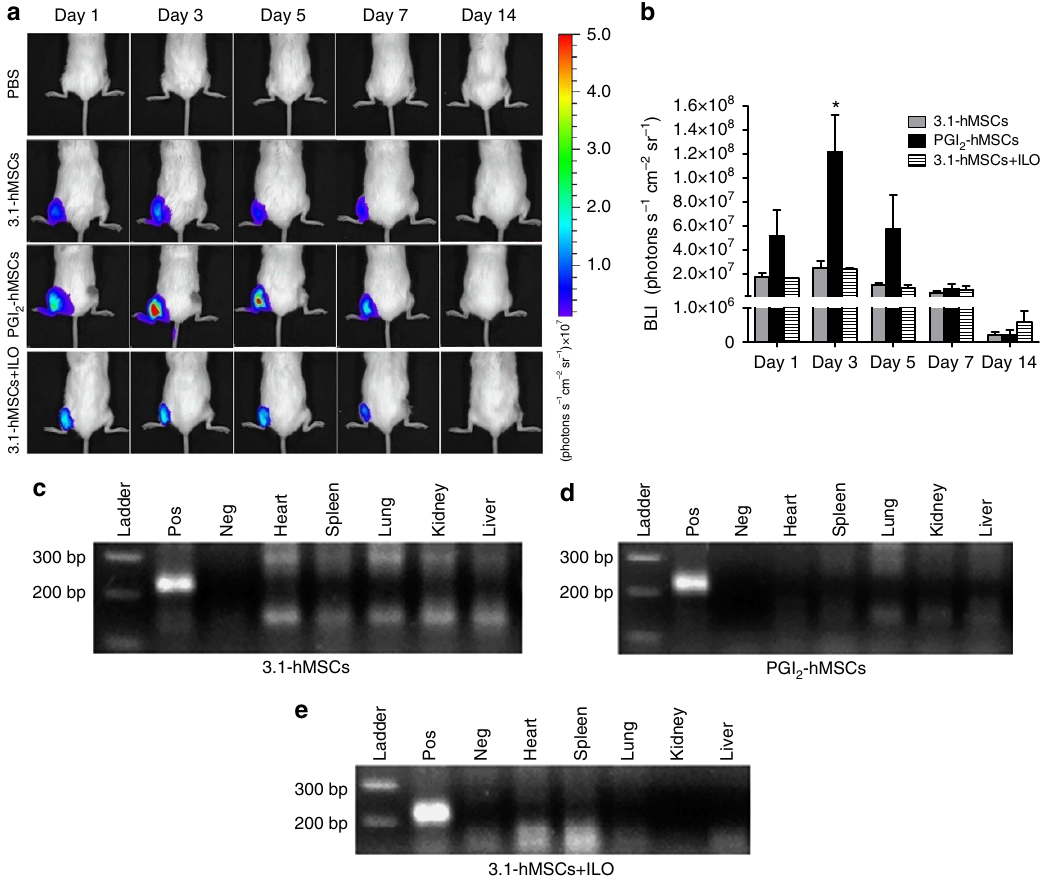
Figure 2 | PGI 2 -hMSCs showed superior acute retention in ischaemic hindlimbs. ( a ) Representative in vivo bioluminescent images of NOD–SCID mice at indicated intervals after injection of vehicle (PBS), 3.1-hMSCs, PGI 2 -hMSCs or 3.1-hMSCs þ ILO into the gastrocnemius muscle of the ischaemic hindlimbs. The minimal noninvasive visualized value was 1 (cid:2) 10 6 photonss (cid:3) 1 cm (cid:3) 2 sr (cid:3) 1 . ( b ) Quantification of maximal bioluminescence in cell-treated ischaemic hindlimbs at the indicated time. * P o 0.05, PGI 2 -hMSCs versus 3.1-hMSCs or versus 3.1-hMSCs þ ILO by a one-way ANOVA with Newman–Keuls post hoc test. Data are shown as mean ± s.e.m. N ¼ 5 mice (male and female) per treatment group. All treatment groups were sex matched. ( c – e ) hMSCs were not detected in the heart, spleen, lung, kidney or liver at 14 days after cell